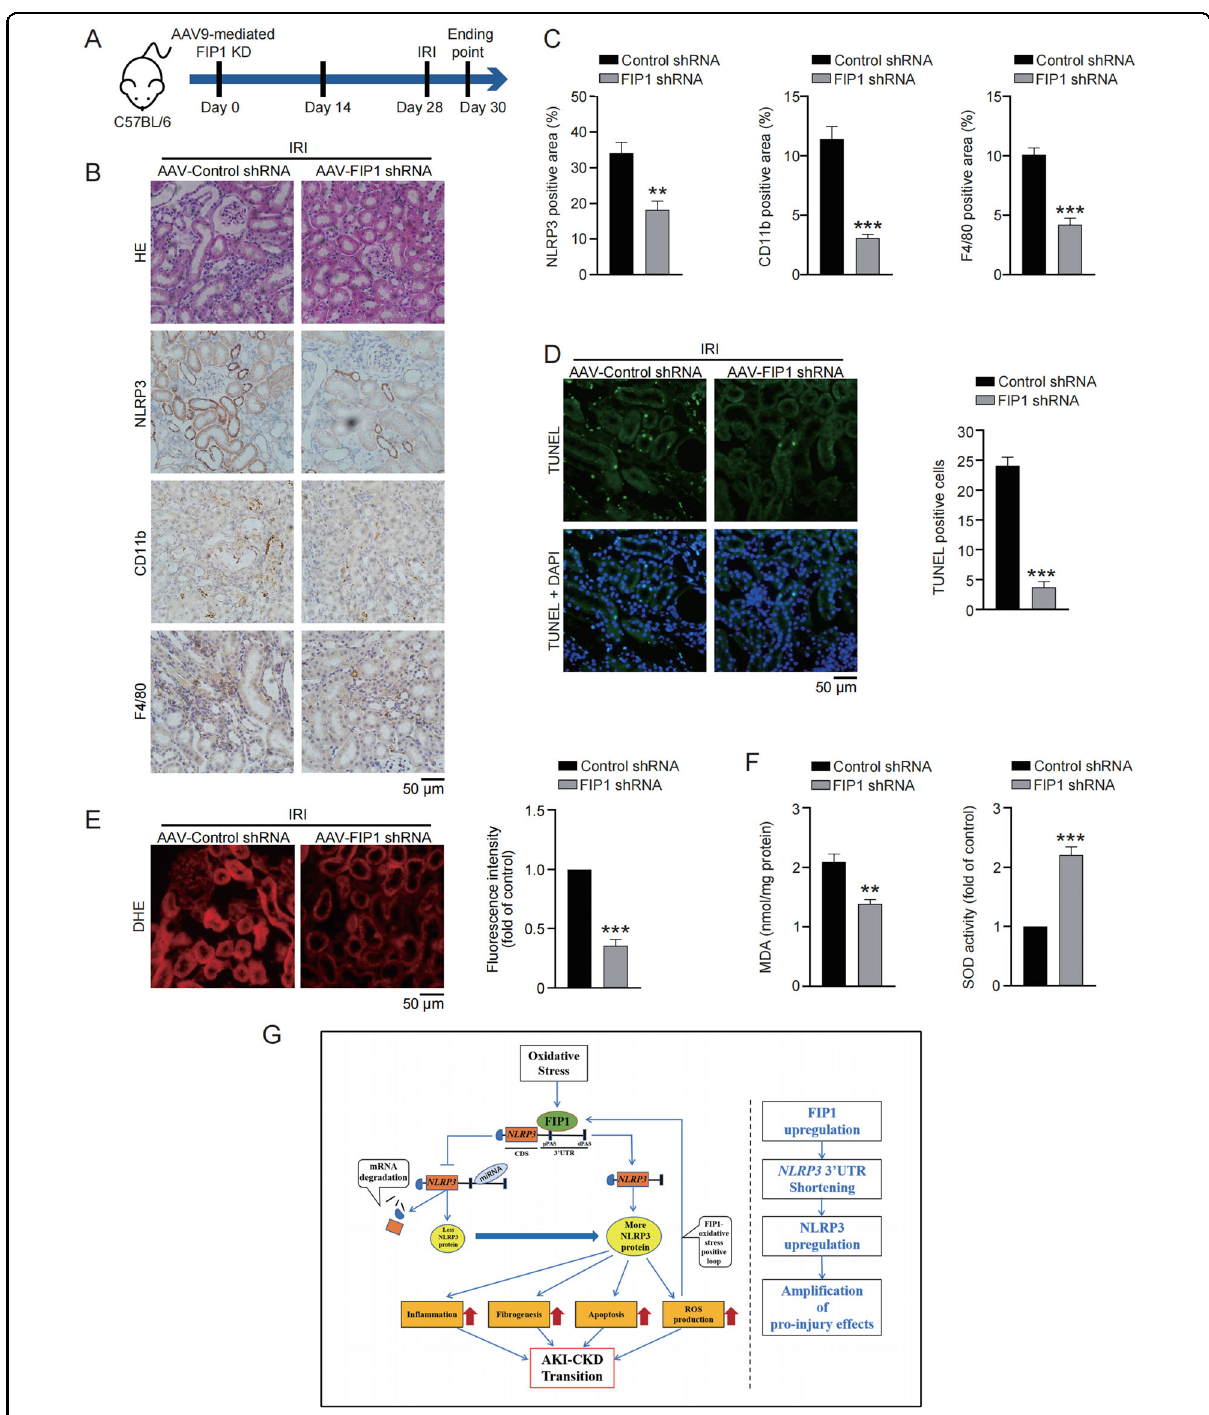
Fig. 8 FIP1 KD alleviates IRI-induced in fl ammation activation, oxidative stress, and apoptosis. A Schematic diagram demonstrating the animal experiment design. B The representative of HE staining and IHC staining for NLRP3, CD11b, and F4/80 in kidney specimens from the indicated group of mice ( n = 5 per group). C Quantitative analysis of IHC staining for NLRP3, CD11b, and F4/80 in kidney specimens from the indicated group of mice. D Representative images and quantitative analysis of TUNEL staining in kidney specimens from the indicated group of mice. E Representative images and quantitative analysis of DHE staining in kidney specimens from the indicated group of mice. F Quantitative analysis of MDA (left) and SOD (right) of mice from the indicated group. G Proposed model of FIP1-induced kidney injury progression and AKI-CKD transition. P < 0.05; ** P < 0.01; *** P < 0.001; All data represent the mean ± SEM obtained from three independent experiments. Student ’ s t